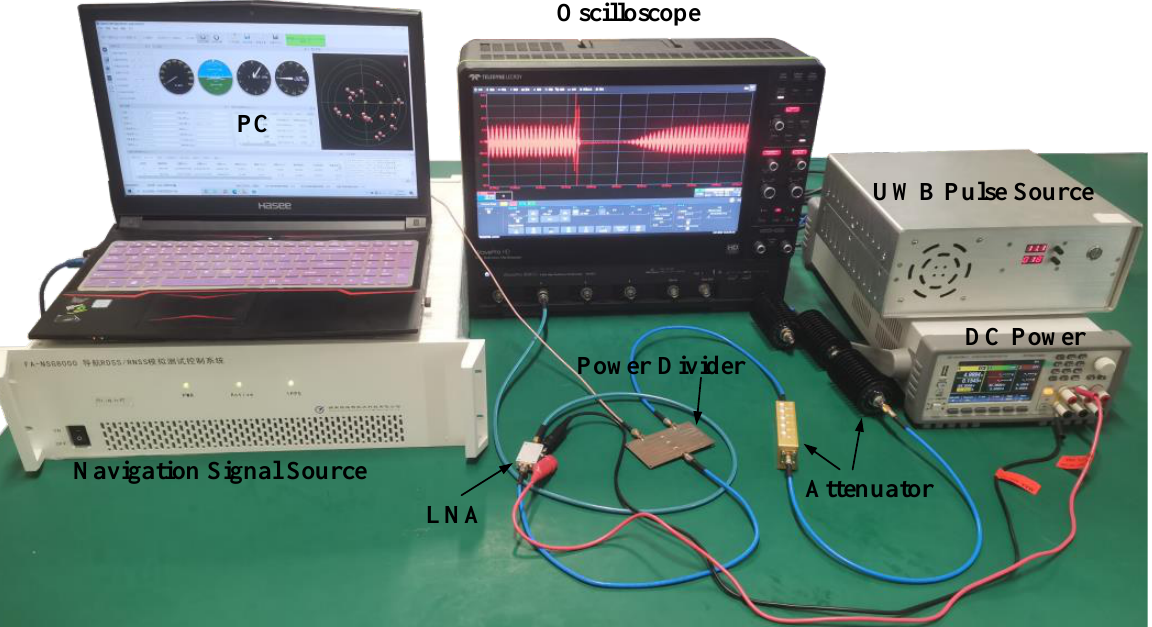
output port of the UWB EMP source. Then, the UWB EMP and BDS-III carrier signal are simultaneously injected into the LNA, as shown in Figure 14. are simultaneously injected into the LNA, as shown in Figure 14.